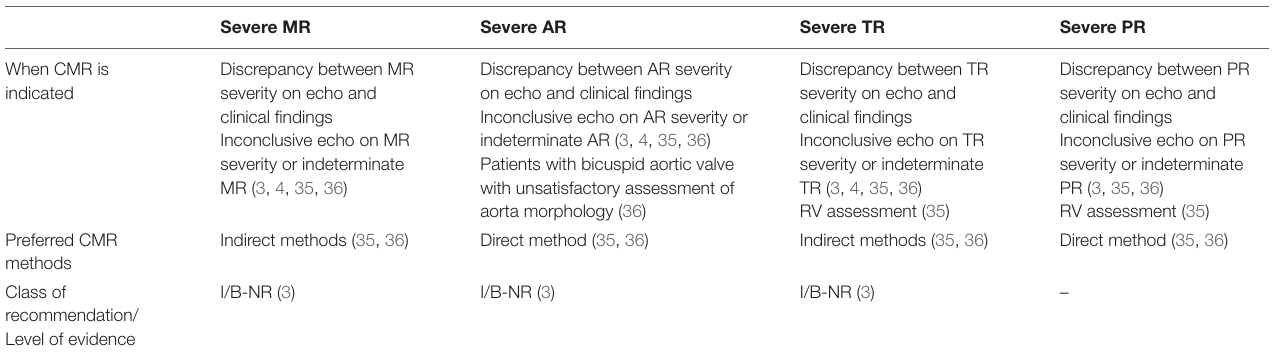
TABLE 4 | Indications, preferred methods and evidence level of CMR to determine severity of mitral, aortic, tricuspid and pulmonary regurgitation according to current American and European guidelines (3, 4, 35,